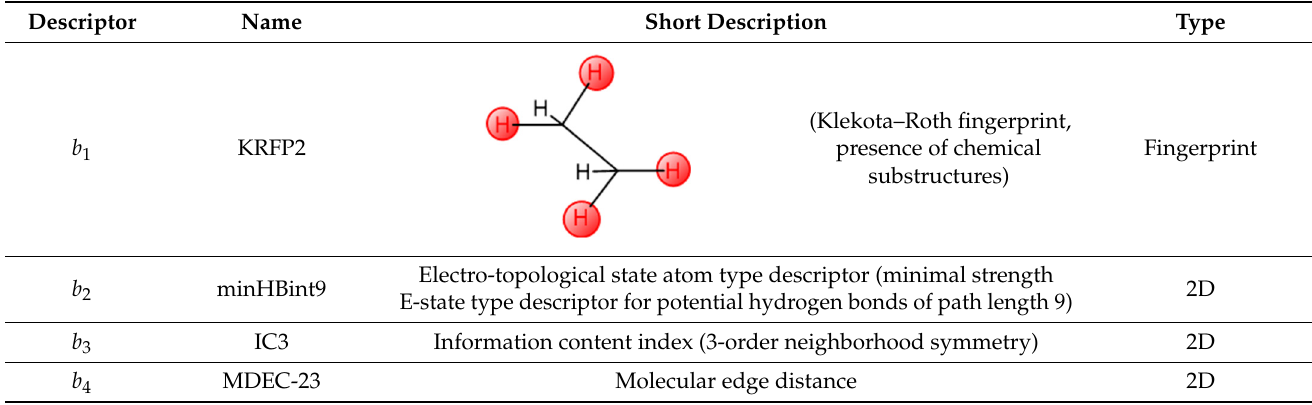
Table 2. Molecular descriptors in the anti- L. amazonensis QSAR model, as described by Equation (2).